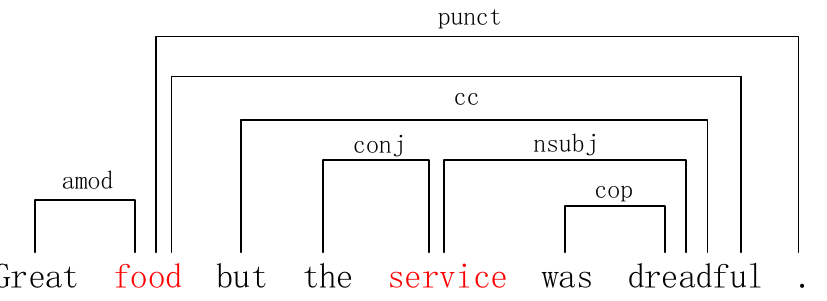
Figure 2. Dependency syntax example 1.